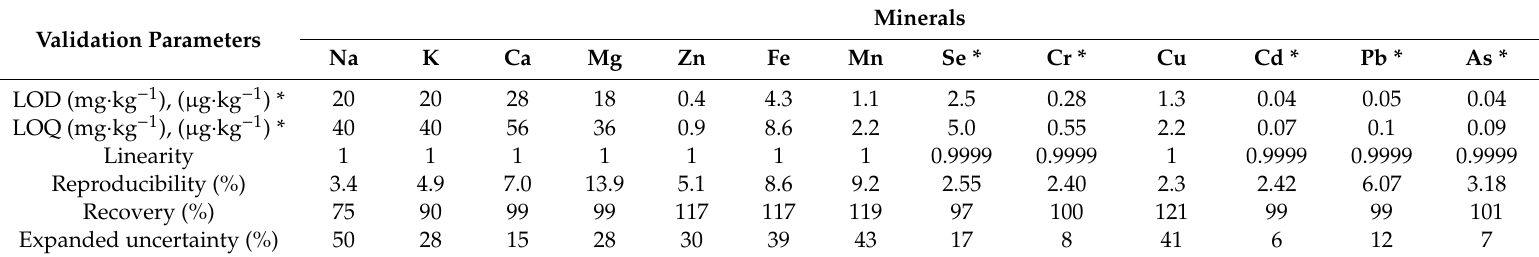
Table 2. Validation parameters of the analytical procedure for the determination of